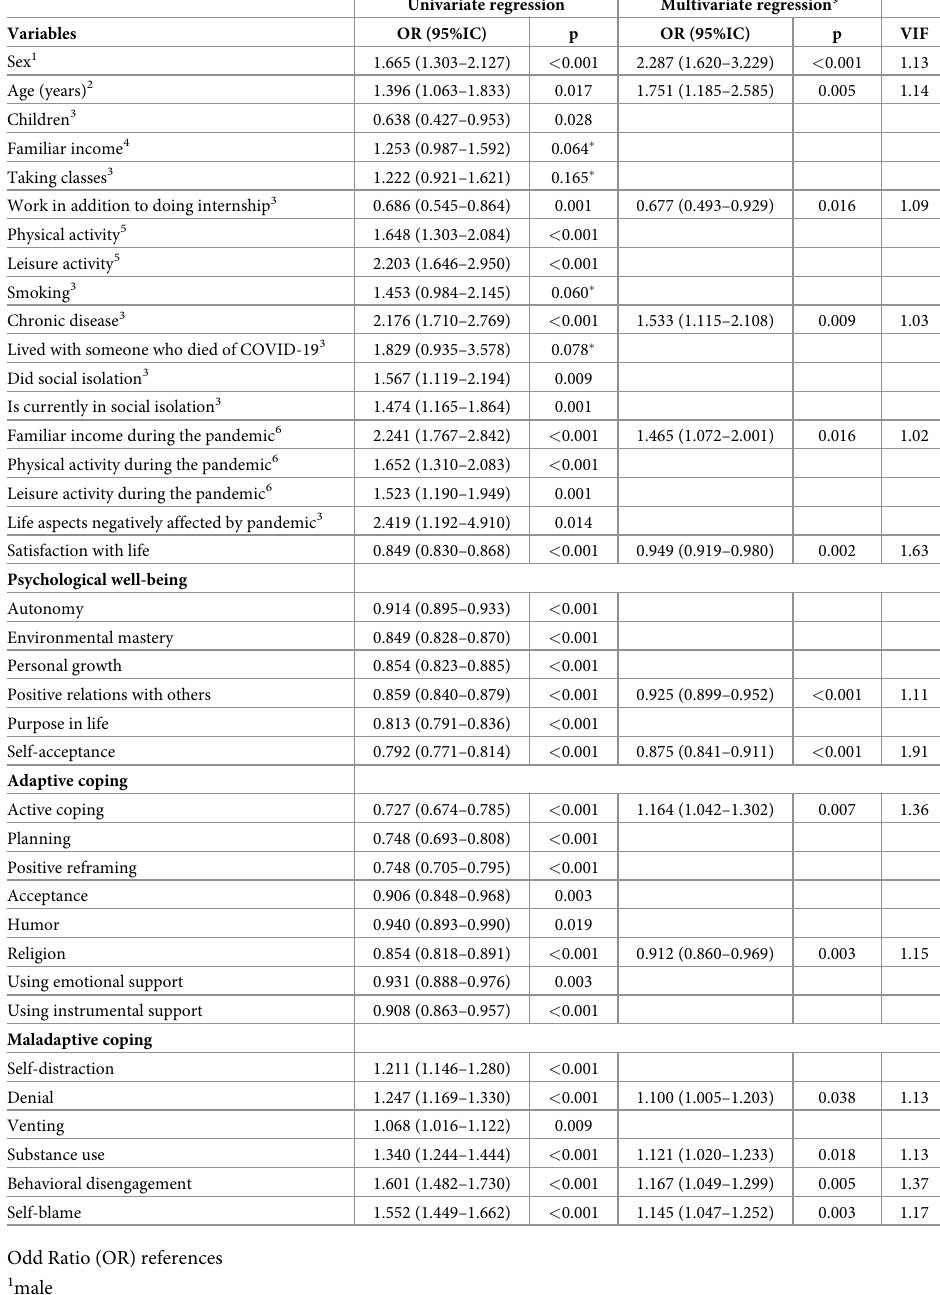
Table 5. Univariate and multivariate logistic regression of independent variables in relation to symptoms of depression in undergraduate students, Parana, Brazil,